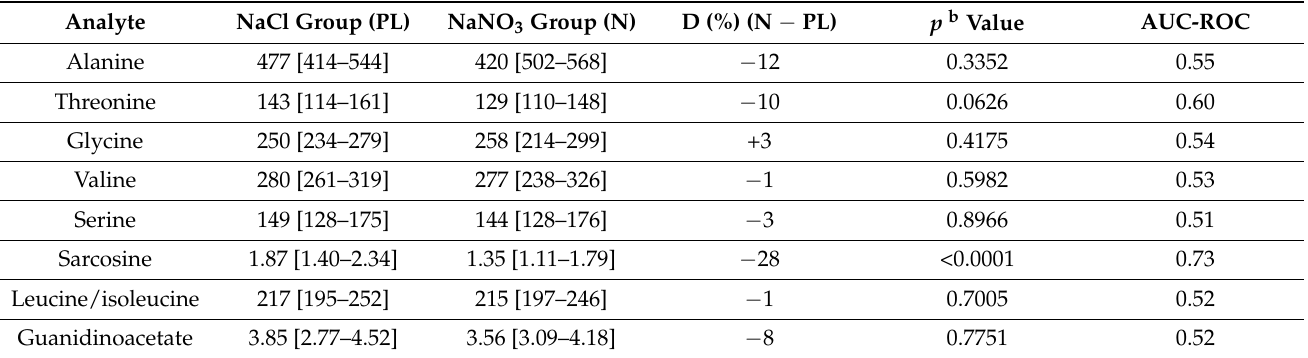
Table 1. Plasma concentrations a of amino acids, creatinine, nitrite, and nitrate and equilibrium constants in the NaCl group (placebo, PL) and NaNO 3 group (N), their percentage difference (D, %), and the area under the curve (AUC) values of the receiver operating characteristic curves